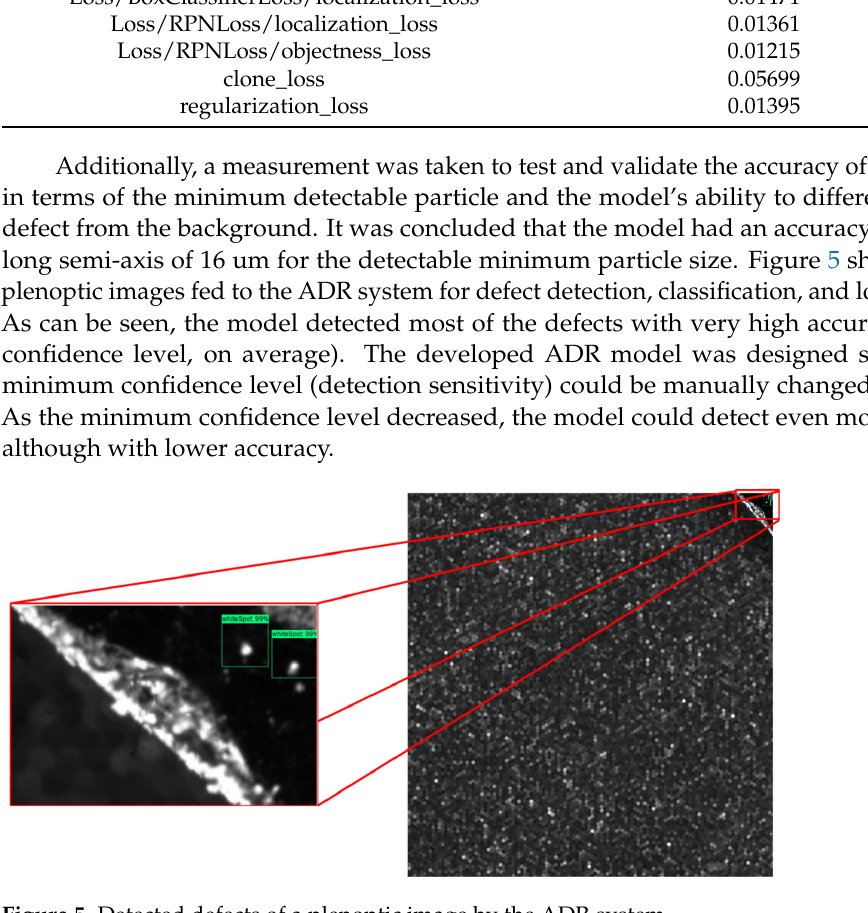
Figure 5. Detected defects of a plenoptic image by the ADR system.